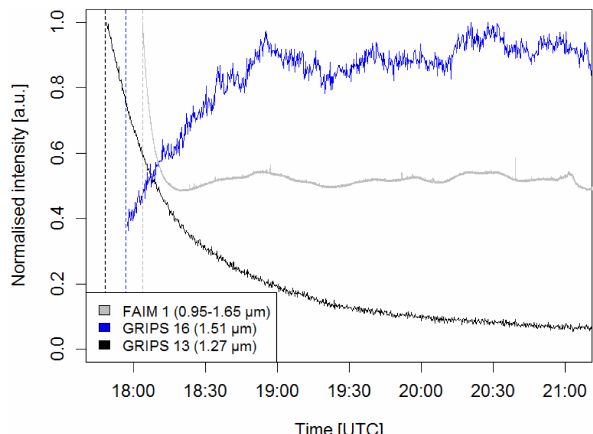
Figure 7. Measurements in the parallel direction of FAIM1 with spectral range from 950 to 1650nm, GRIPS13 adjusted for mea- suring 1.27µm O 2 (0-0)-transition and GRIPS16 for the OH(3-1)- Q-branch-transition at 1.51µm for the first 3h of the night. The case study shows an exponential decay of O 2 and an increase of OH in- tensity. The FAIM time series (averaged over the FOV of GRIPS13) shows a mixture of both